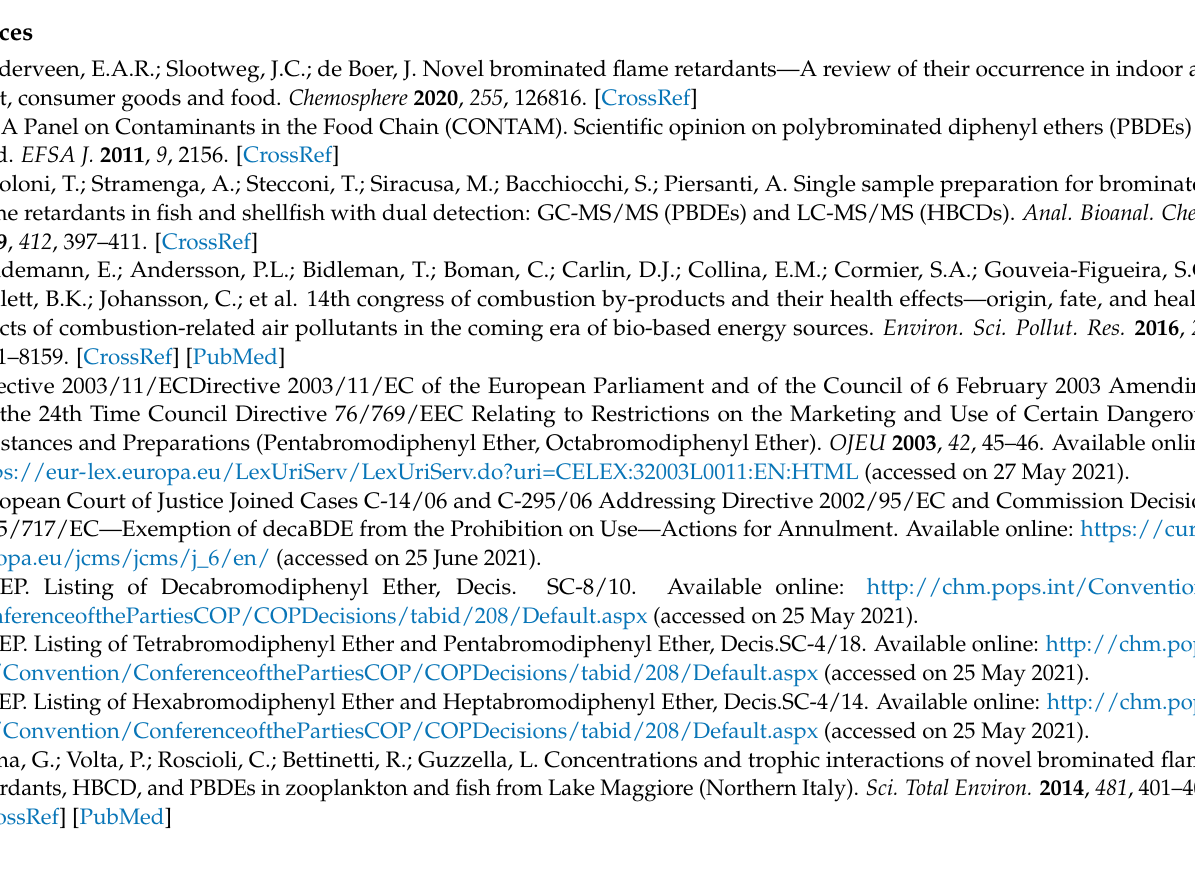
Table S3. Values of benefit-risk quotient related to the consumption of freshwater fish products from Trasimeno Lake (LB = lower bound, UB = upper bound, BDE =brominateddiphenyl ether, Σ HBCD = sum of hexabromocyclododecanes), Table S4. Values (pg/g) of polybrominateddiphenyl ethers (PBDEs) and hexabromocyclododecanes (HBCDs) for perch ( Perca fluviatilis, n = 10) caught in Piediluco